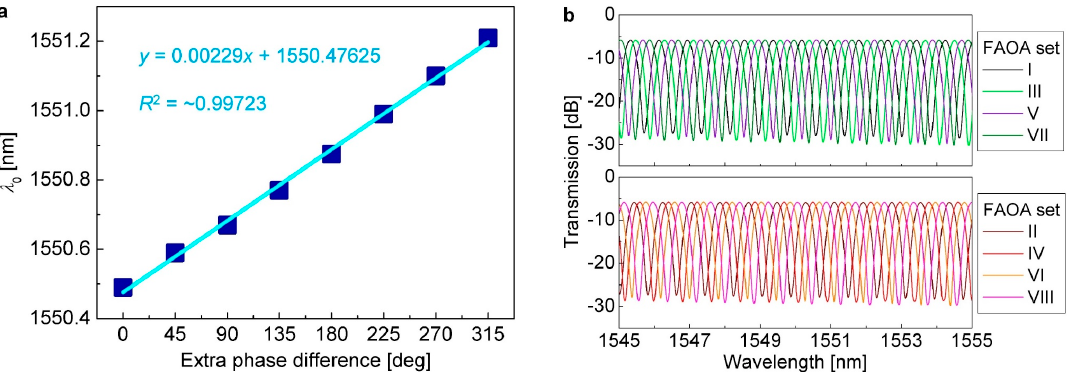
Figure 6. ( a ) Variation of the peak wavelength denoted by λ 0 in Figure 5, measured at the eight FAOA sets and ( b ) two superimposed plots with four narrowband transmission spectra measured at the FAOA sets I, III, V, and VII in upper plot and four narrowband transmission spectra measured at the FAOA sets II, IV, VI, and VIII in lower plot.